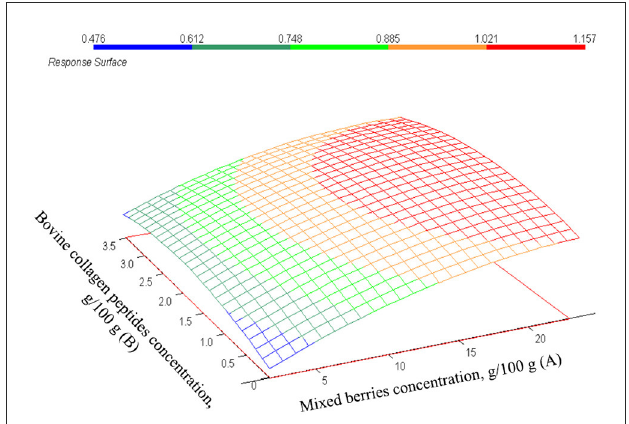
FIGURE6 The estimated values of FRAP g/L in function of mixed berries concentration (A) and bovine collagen peptides concentration (B).